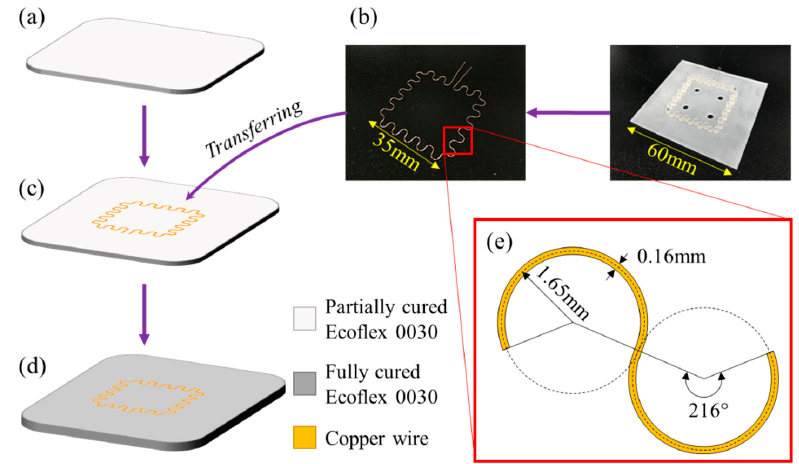
Figure 2. Fabrication process of the wireless strain sensor: ( a ) curing the substrate partially, ( b ) patterning the copper wire in serpentine shape, ( c ) transferring the pattern and ( d ) curing the device completely. ( e ) Detailed design of the serpentine pattern of the coil.